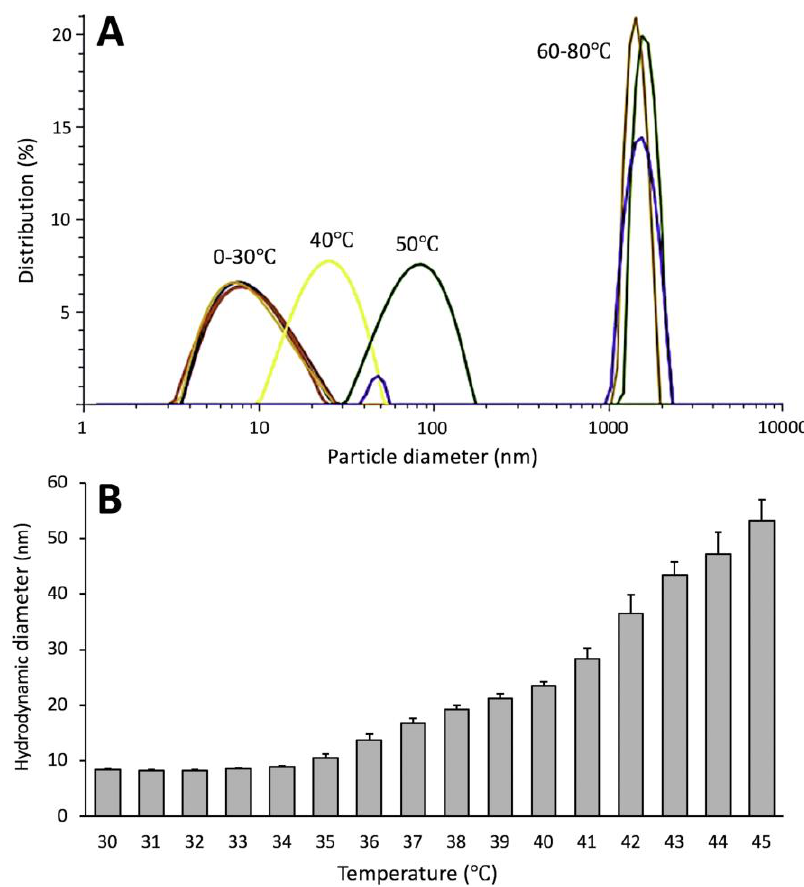
Figure 4. Thermostability of Tyrp1tr determined by DLS. Panel A: Particle diameter distribution by intensity for Tyrp1tr at 2 mg/mL measured at temperature range of 0–80 °C, at 10 °C intervals. Panel B: Hydrodynamic diameter of the same Tyrp1tr protein sample measured at the temperature range of 30–45 °C, at 1 °C intervals.